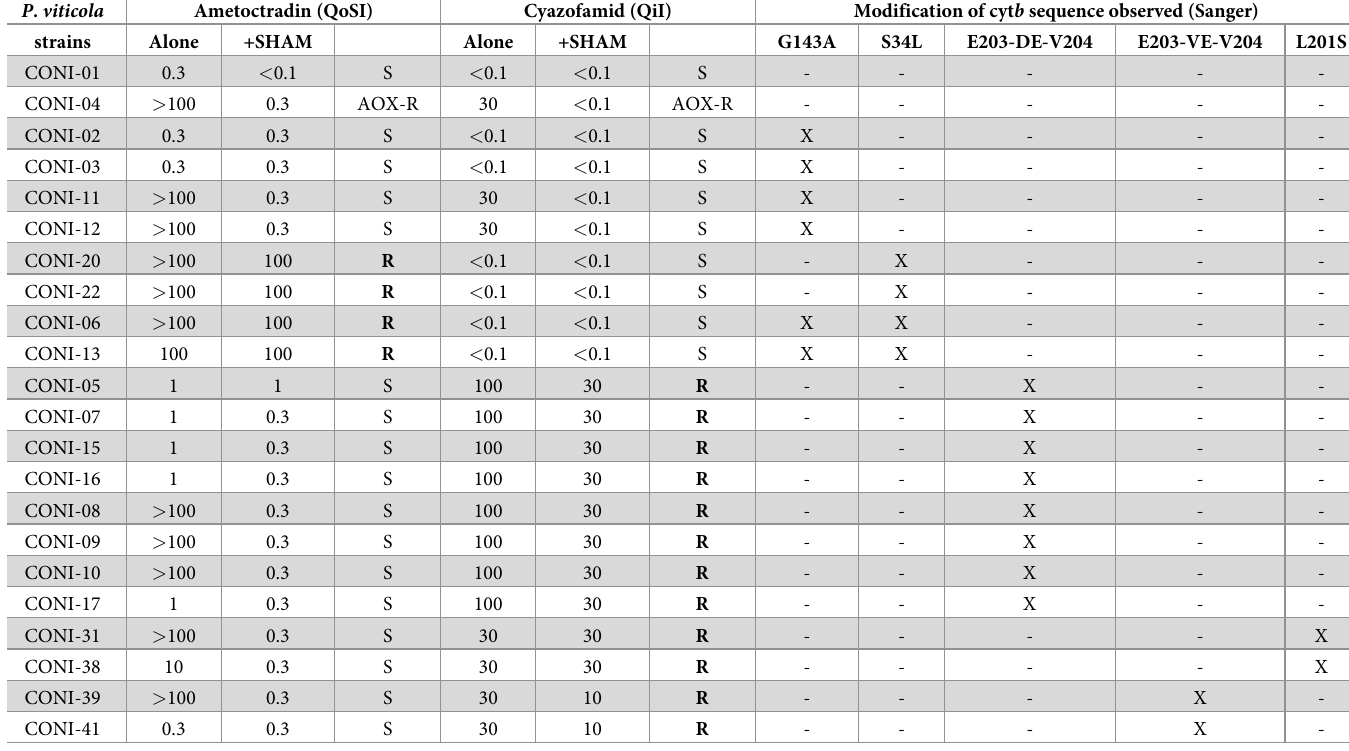
Table 1. MIC (Minimum Inhibitory Concentration) values for ametoctradin and cyazofamid observed for single-sporangia strains isolated from field-collected P . viticola populations and associated mutations or insertions detected in their cyt b gene compared to the reference